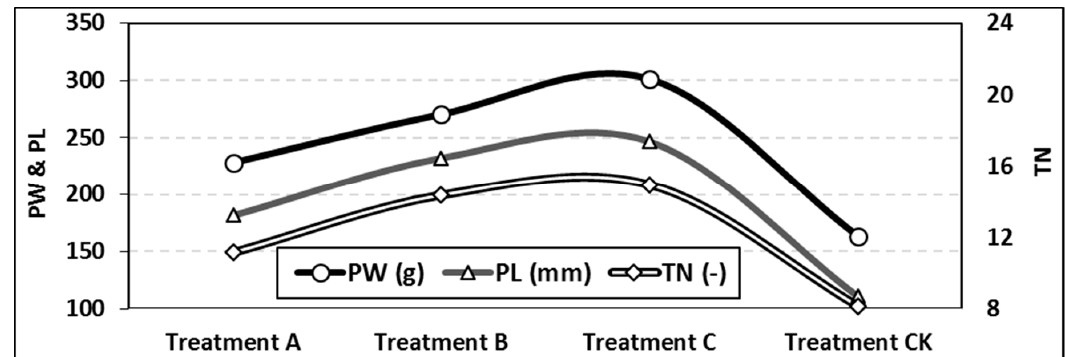
Figure 7. Plot depicting the trends in the effect of biochar depth on selected rice yield components after removal of the effects of contingent field conditions of water logging and pest damage. Note that PW = plant weight, PL = plant length, and TN = tiller number.